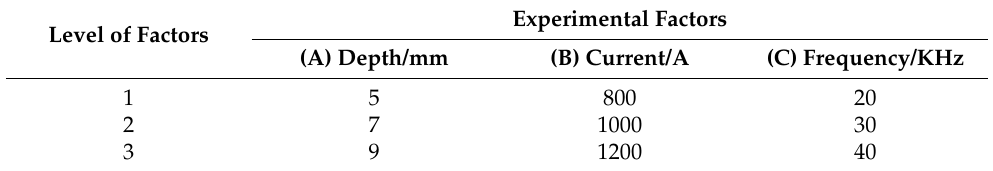
Table 3. Levels of experimental factors. Level of Factors